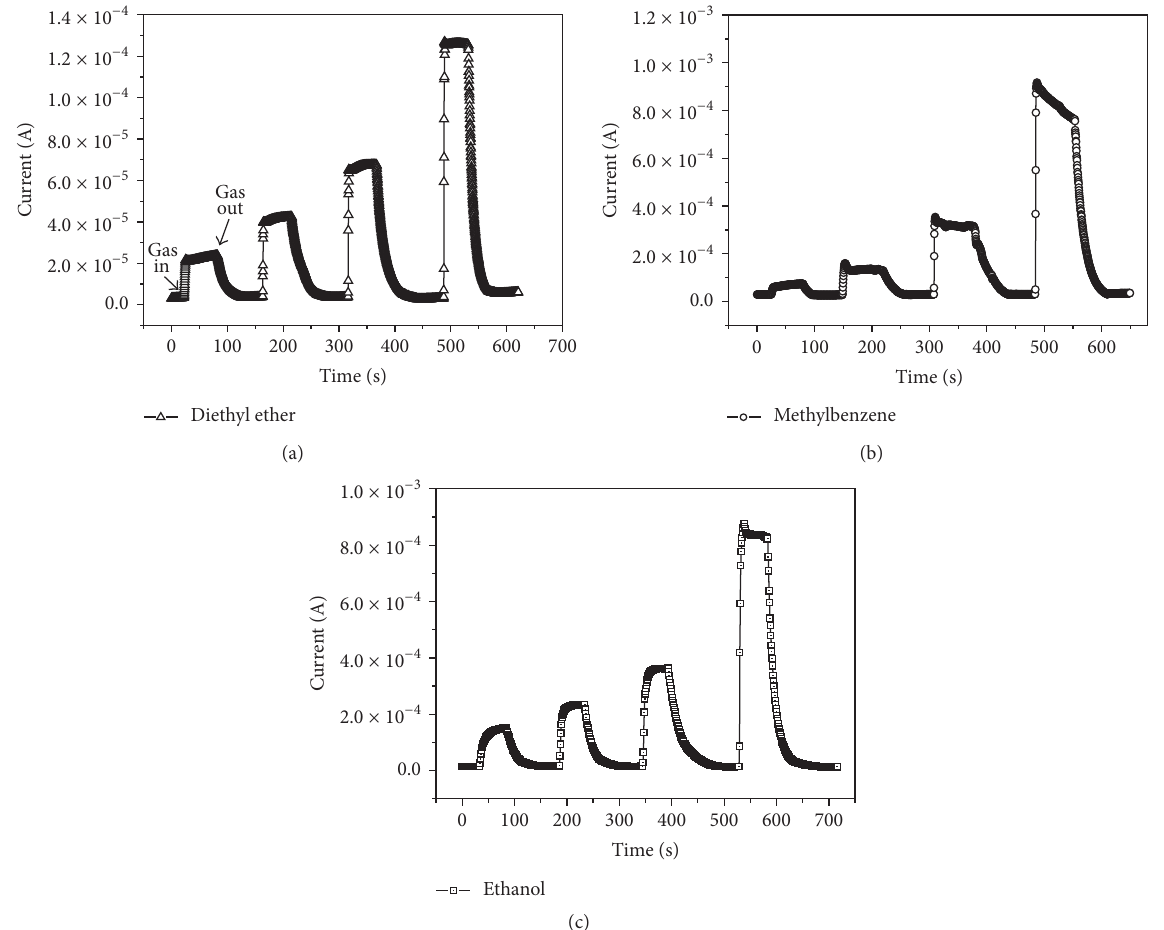
Figure 5: Real-time sensing curves of the snowflake-shaped ZnO-based gas sensor to (a) diethyl ether, (b) methylbenzene, and (c) ethanol. Target gas in/out during measurements was indicated in (a).